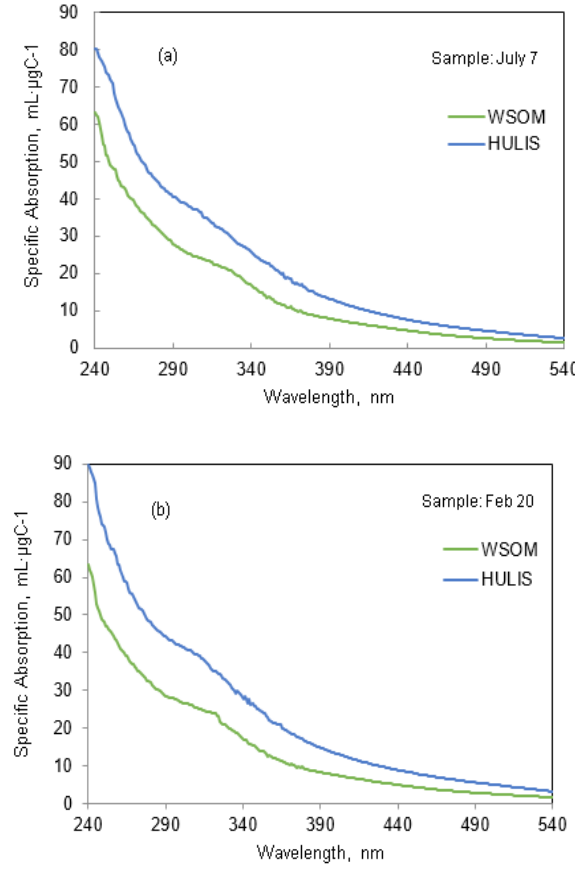
Fig. 2. Absorption spectra of WSOC and HULIS, isolated by the DEAE method (samples collected at the